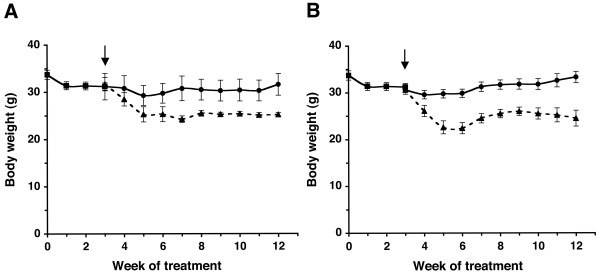
Influence of diet on body weight in adult EL mice fed the SD (A) or the KD (B). Squares represent the pre-trial period when all mice were fed the SD-UR. Circles and triangles represent the UR-fed and R-fed groups, respectively. Values are expressed as the mean ± SEM (n = 6 mice per group). Arrow indicates initiation of CR.